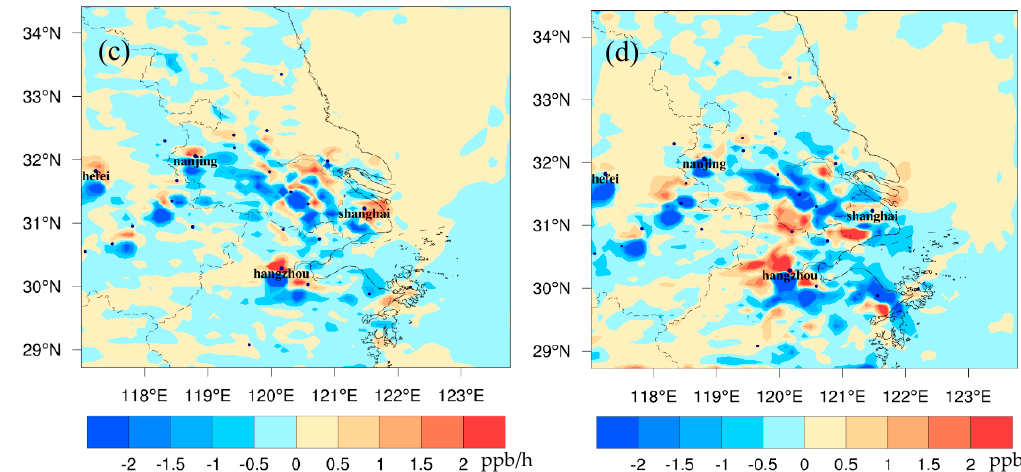
Figure 5. The spatial distribution of the monthly averaged differences of the VMIX processes of NOx Vmix_NO x ( a , b ) and the ADVT processes of NOx Advt_NO x ( c , d ) between FUTMET and PREMET.